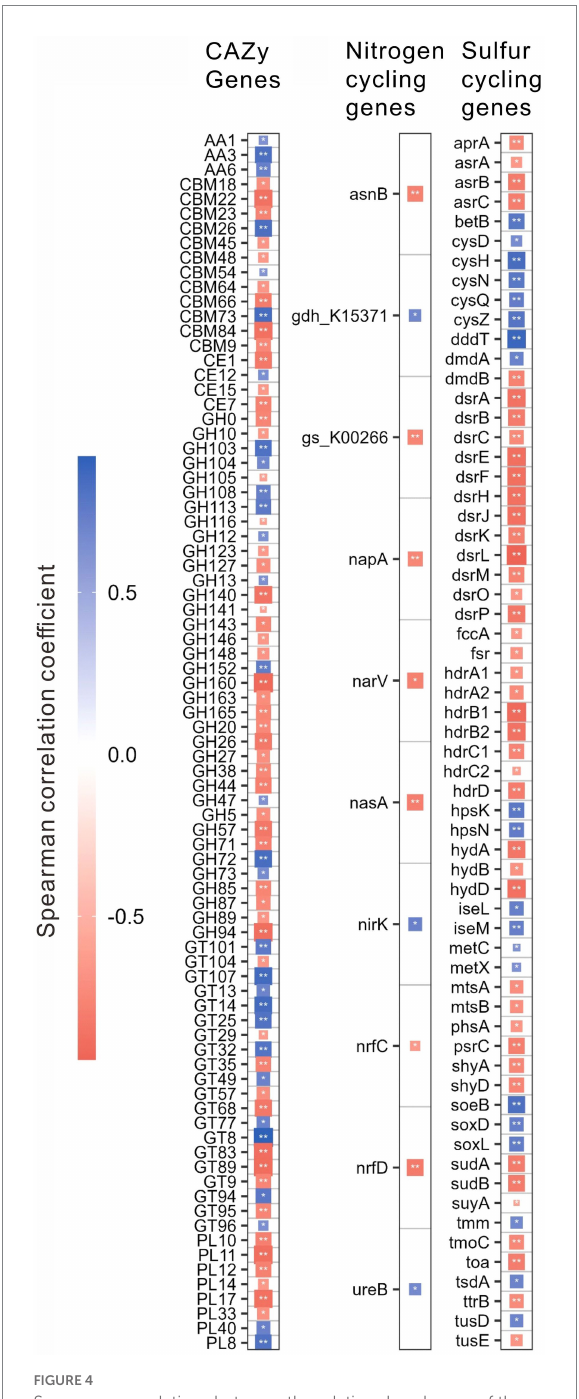
FIGURE 4 Spearman correlations between the relative abundances of the specifical genes related to the CAZy, nitrogen, and sulfur cycling and salinity in the studied lake sediments. Only significant ( p < 0.01) correlations are shown in the figure. * p < 0.01, ** p <